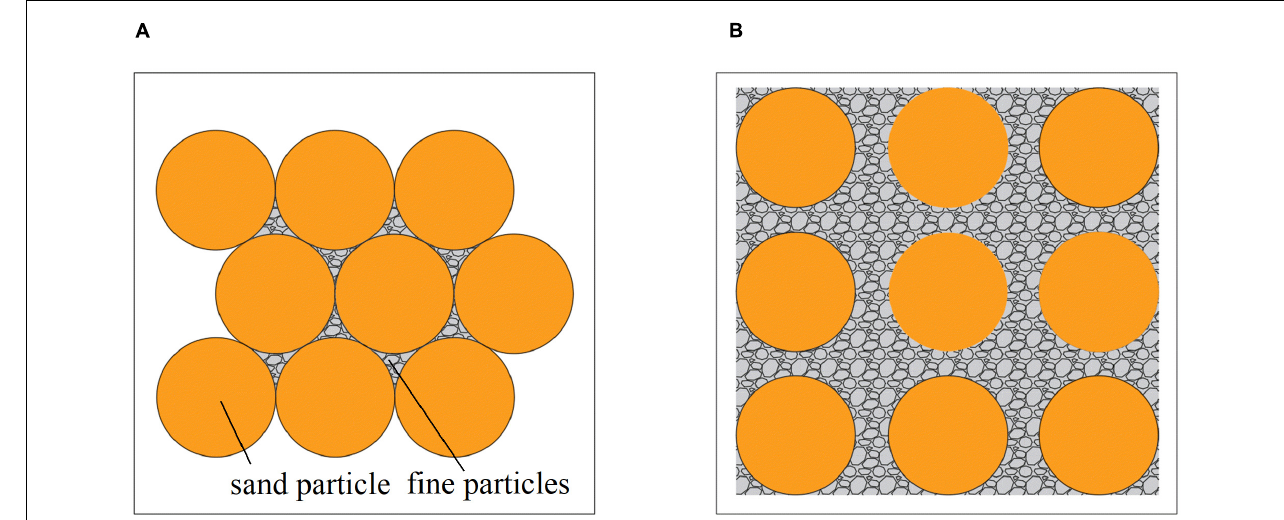
interparticle attractive forces (the van der Waals forces) between